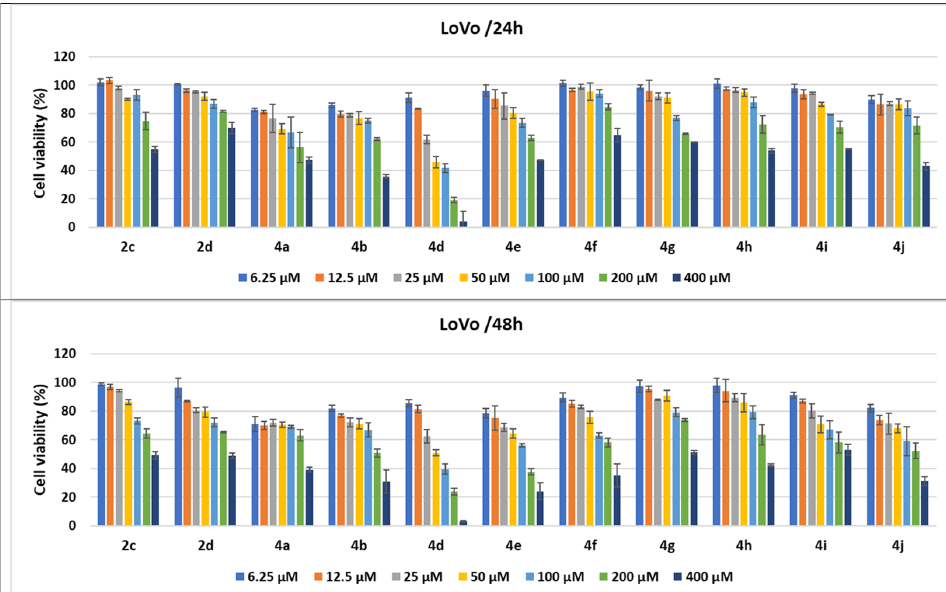
Figure 10. Antitumor effect of pyrrole derivatives against LoVo colon cancer cells. The viability of the LoVo cells was measured after treatments with scalar concentrations of pyrrole compounds for 24 or 48 h and compared to that of untreated control cells. Data are expressed as the mean values ± standard deviations (SDs) of three different experiments ( n = 3 ).